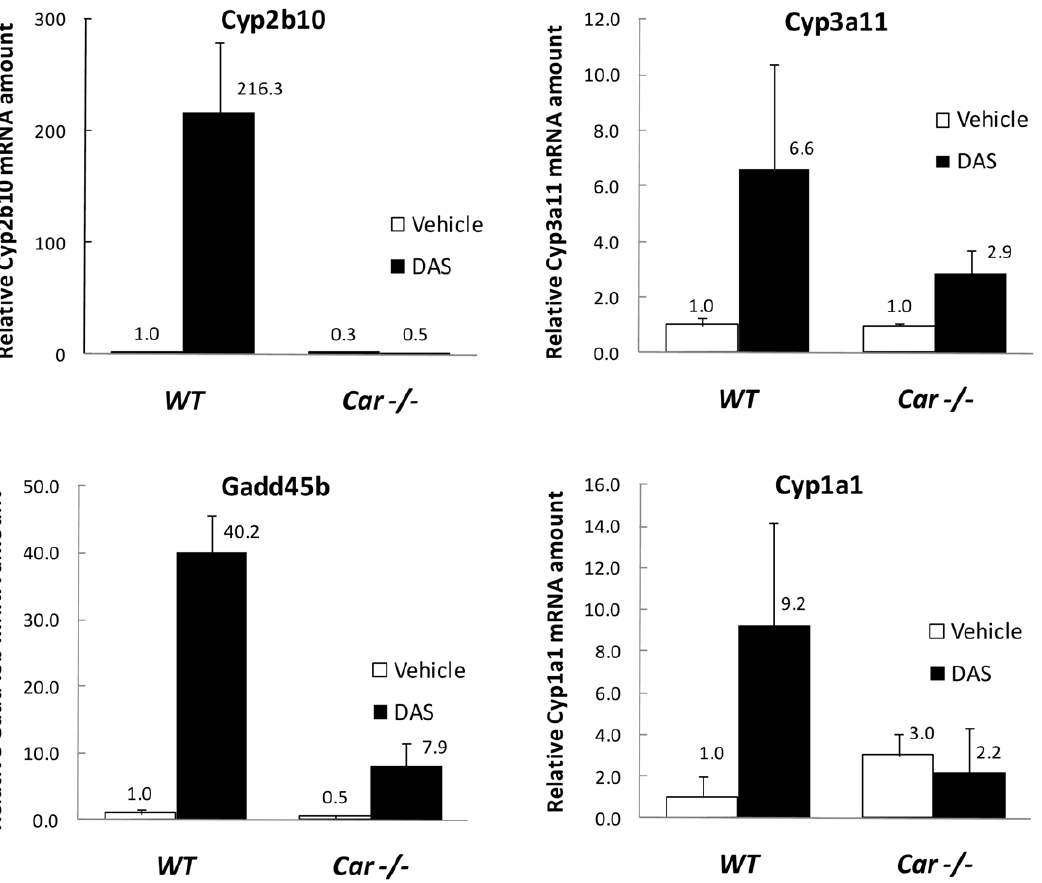
Figure 2. Gene activation by DAS. The expression of Cyp2b10 , Cyp3a11 , Gadd45b and Cyp1a1 genes was analyzed in DAS treated and vehicle treated mice livers. The same RNA samples treated with vehicle or DAS from wild type and Car null mice liver used in FIG. 1A were analyzed to determine the expression of these genes.